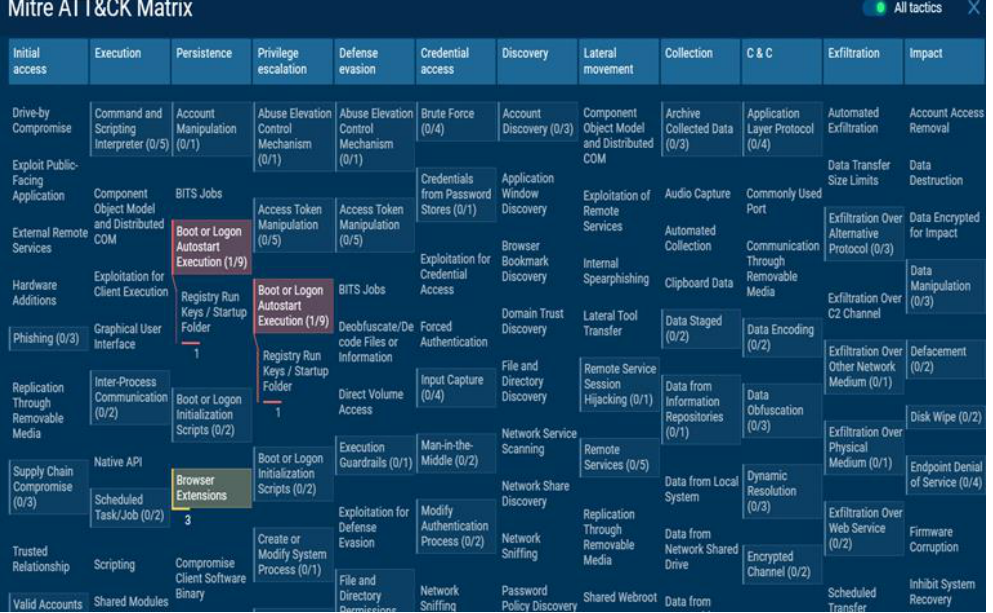
Figure 14. Implementation of MITRE ATT&CK framework and visualization of malicious file dy- namic analysis results (1).